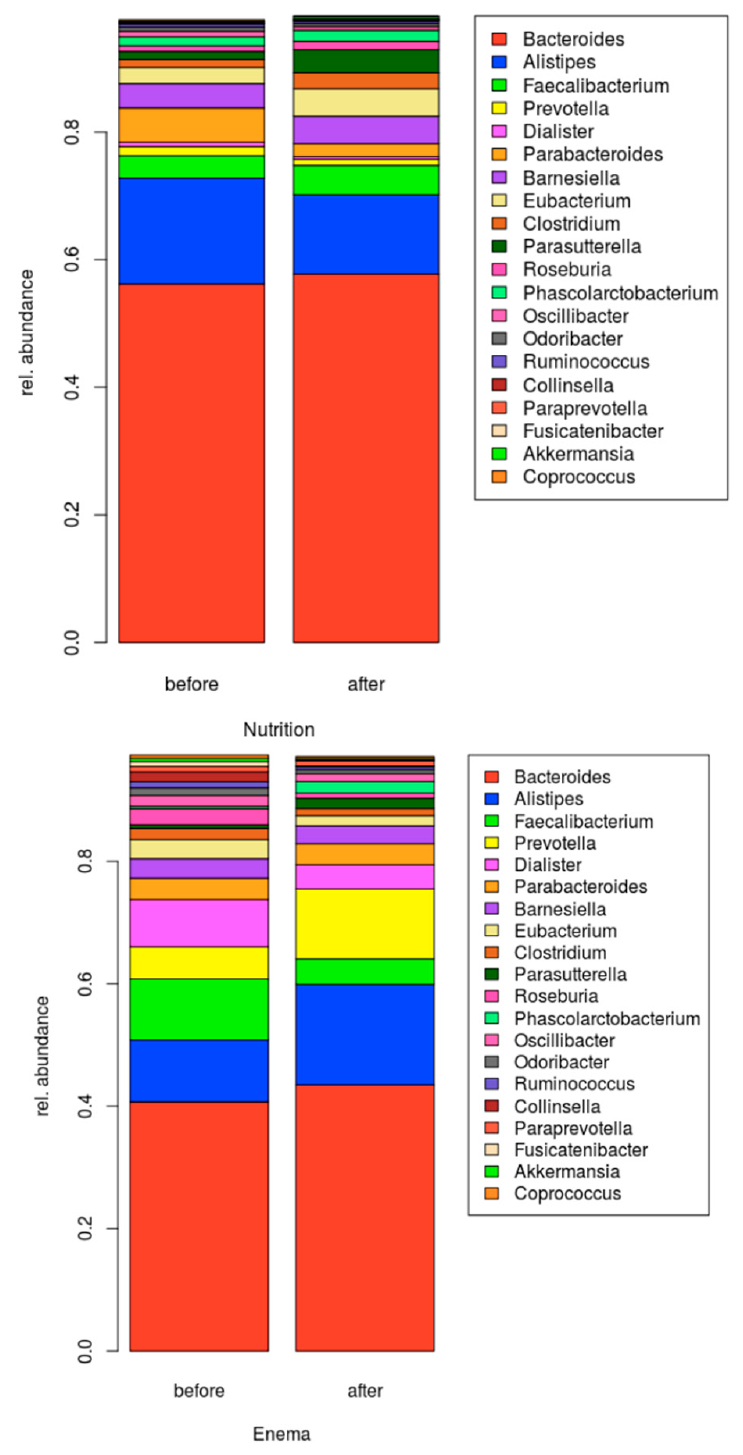
Figure 6. Relative abundance of the genus level in patients with Parkinson disease before and after